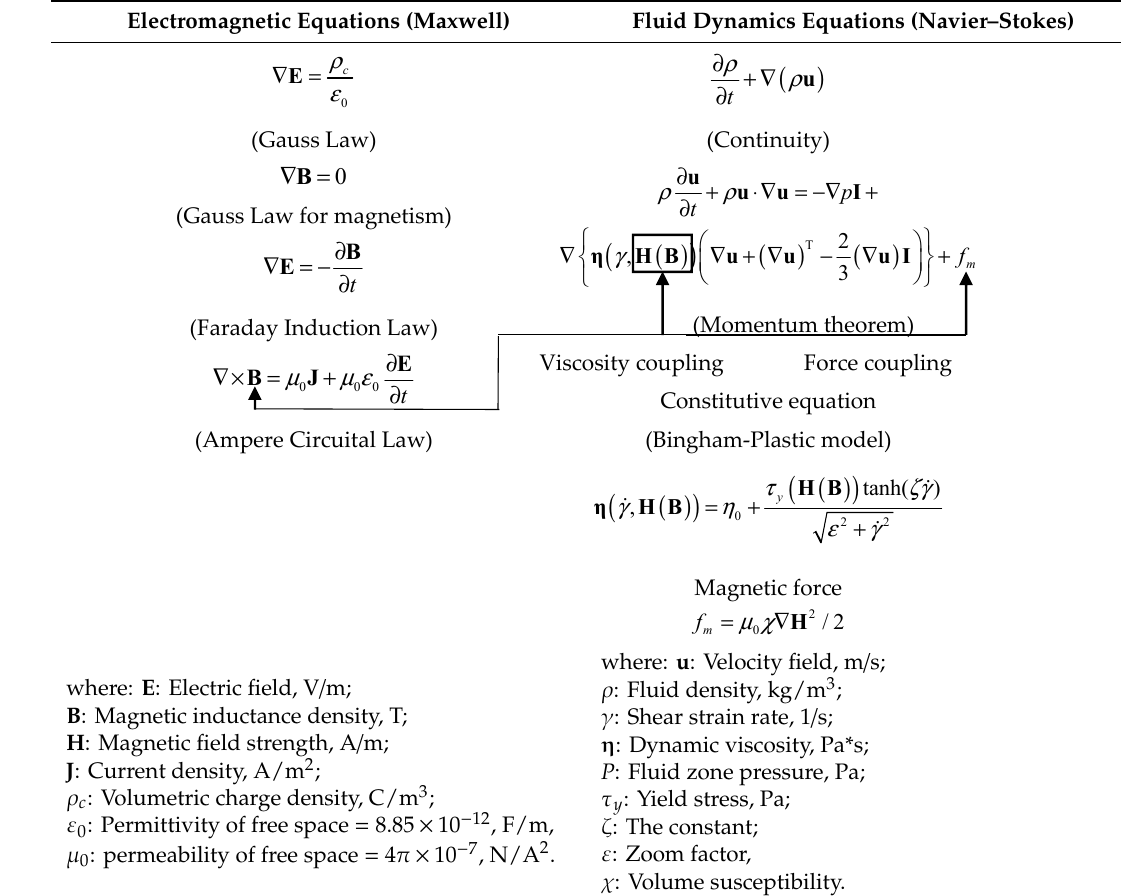
Figure 8. Multi-physical field model of the MR buffer. Table 3. Multi-physical field